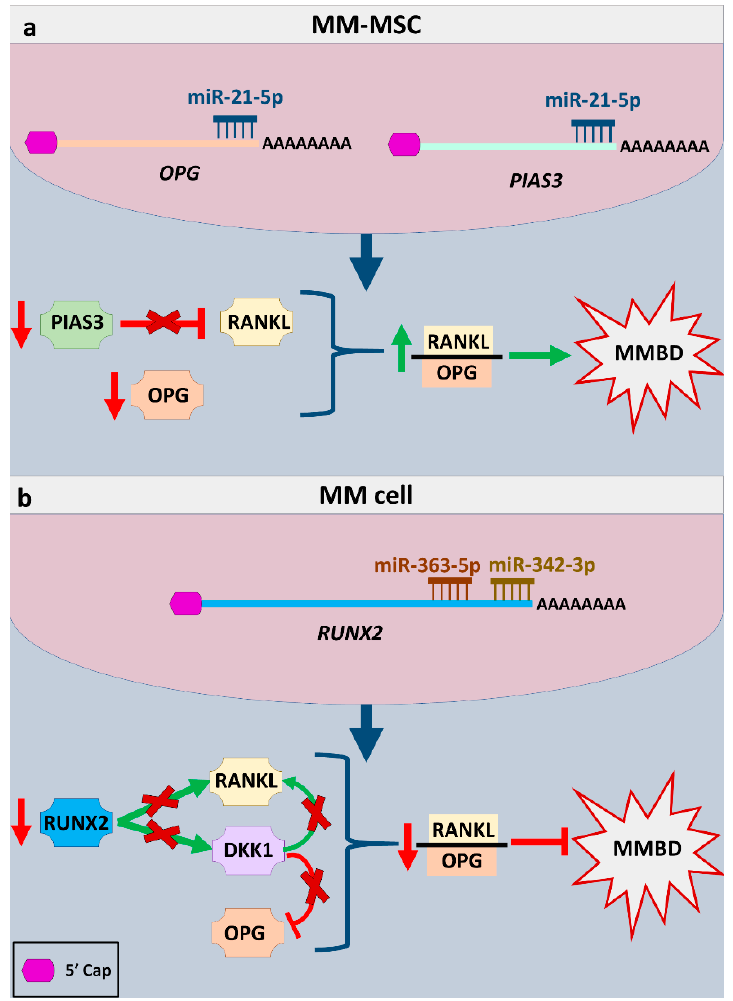
Figure 2. Two typical examples of miRNAs implicated in MMBD through the regulation of specific pathways. ( a ) miRNA action leads to an increase of the RANKL/OPG ratio and promotes MMBD through inhibiting OPG and PIAS3 , a RANKL inhibitor; ( b ) miRNA action leads to the decrease of this ratio through inhibiting RUNX2 , and its downstream targets, RANKL and DDK1, which is an OPG inhibitor. Abbreviation: MM-MSC, multiple myeloma mesenchymal stem cell.